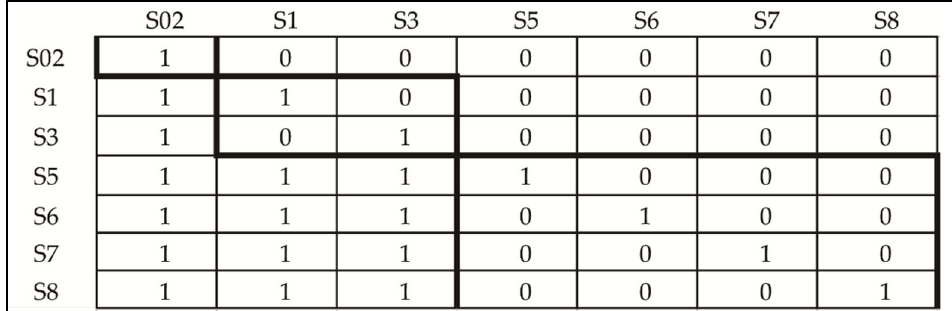
Figure 5. Reachability matrix after participating in decision ranking.